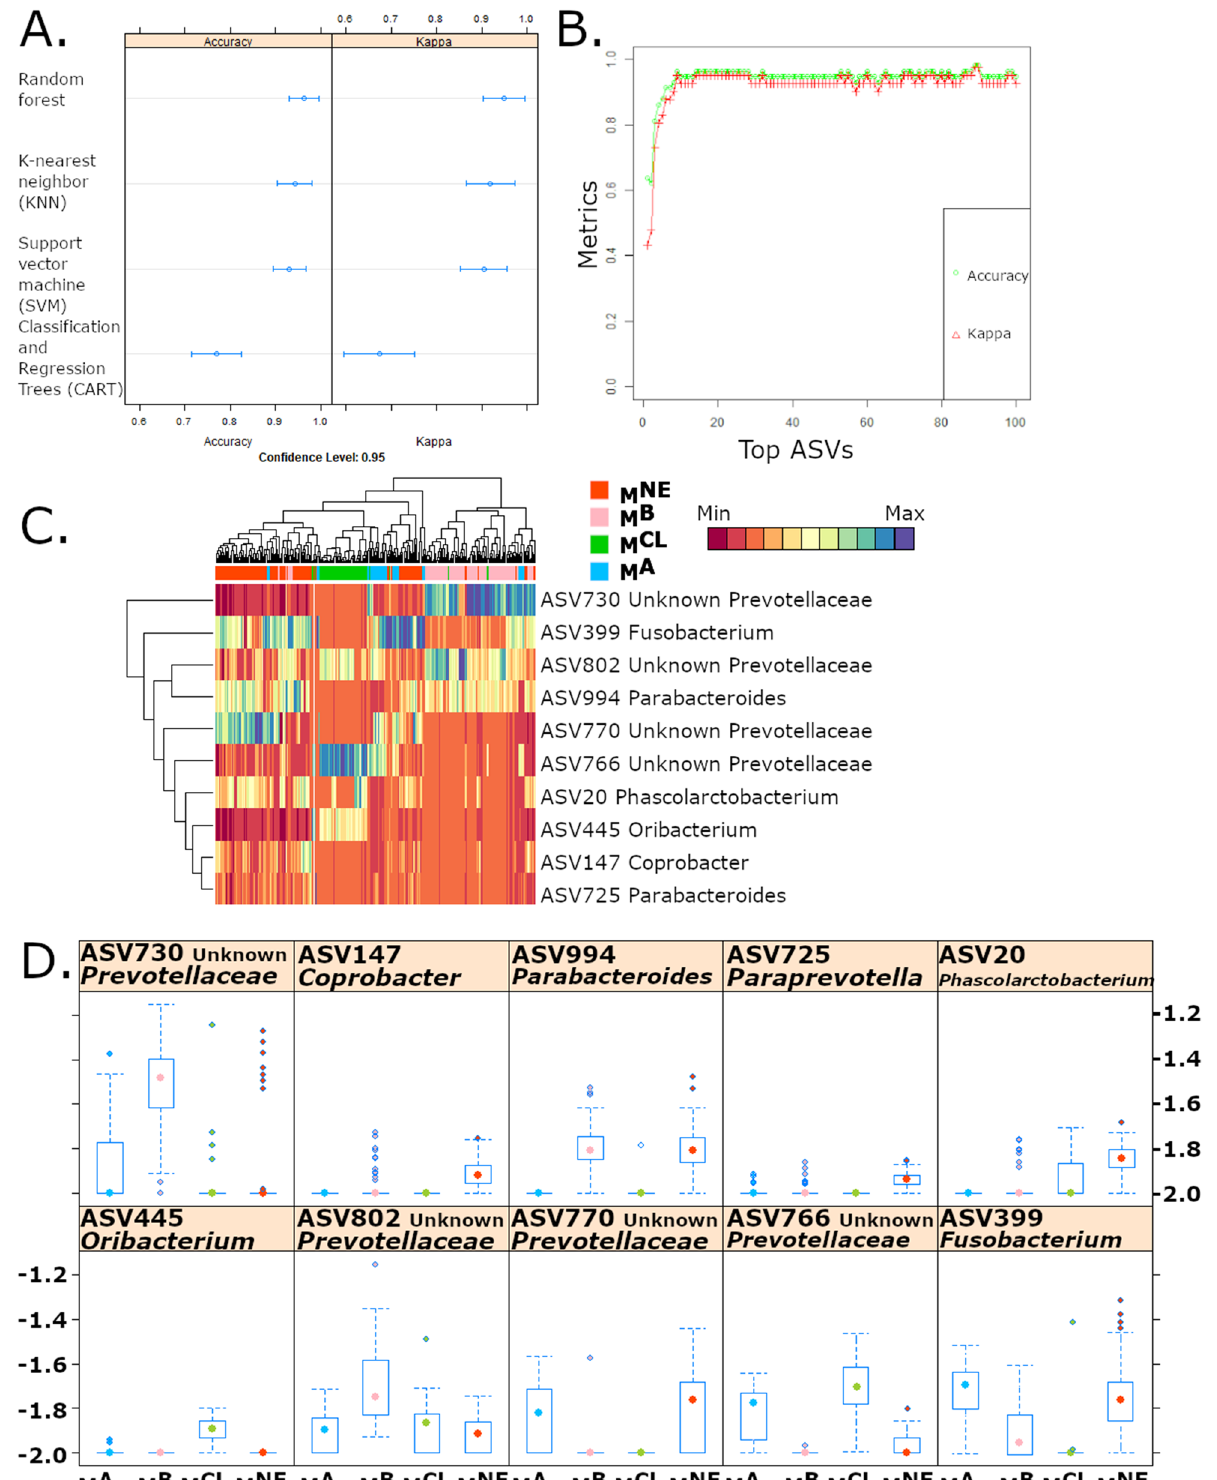
Figure 2. ( A ) Comparison of classifier models used to classify healthy microbiomes based on source included random forest (RF), K-nearest neighbor (KNN), support vector machines (SVM), and classification and regression trees (CART). RF consistently outperformed the other classifiers. ( B ) Accuracy and Kappa of RF model stabilizes with 10 variables. ( C ) Heatmap of ASV abundances showing classification of data using 10 ASVs. Color bar on top indicates source. ( D ) Boxplots of 10 ASVs selected by RF model show source-specific